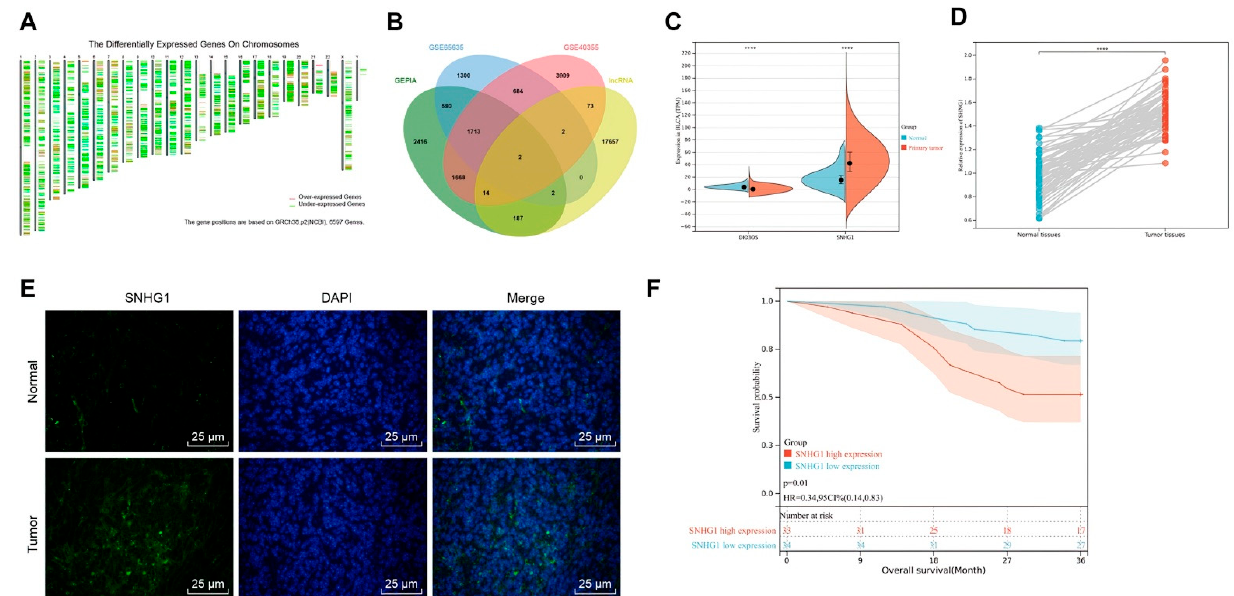
Figure 1. SNHG1 is upregulated in bladder cancer tissues in association with poor prognosis of patients with bladder cancer. ( A ) GEPIA: http://gepia2.cancer-pku.cn/ (accessed on 6 June 2021) analysis of the location map of differentially expressed genes obtained from BLCA data in TCGA database: https://portal.gdc.cancer.gov/ (accessed on 6 June 2021). Chromosomes 1-22, X and Y are shown in turn from left to right. ( B ) Venn diagram of the intersection of significantly differential genes obtained from GEPIA analysis, GSE65635, and GSE40355 and human lncRNA obtained from GENCODE: https://www.gencodegenes.org/human/ (accessed on 7 June 2021) (intersecting genes were DIO3OS and SNHG1). ( C ) UALCAN: http://ualcan.path.uab.edu/index.html (accessed on 7 June 2021) analysis of TCGA database showing that DIO3OS expression was significantly low in bladder cancer, while SNHG1 expression was significantly high in bladder cancer. ( D ) qRT-PCR detection of SNHG1 expression in 40 cases of bladder cancer and adjacent tissues. ( E ) RNA-FISH detection of SNHG1 expression in 40 cases of bladder cancer and adjacent tissues (400×, scale bar = 25 µm). ( F ) Kaplan–Meier analysis of SNHG1 and patient survival curve. **** p < 0.0001.